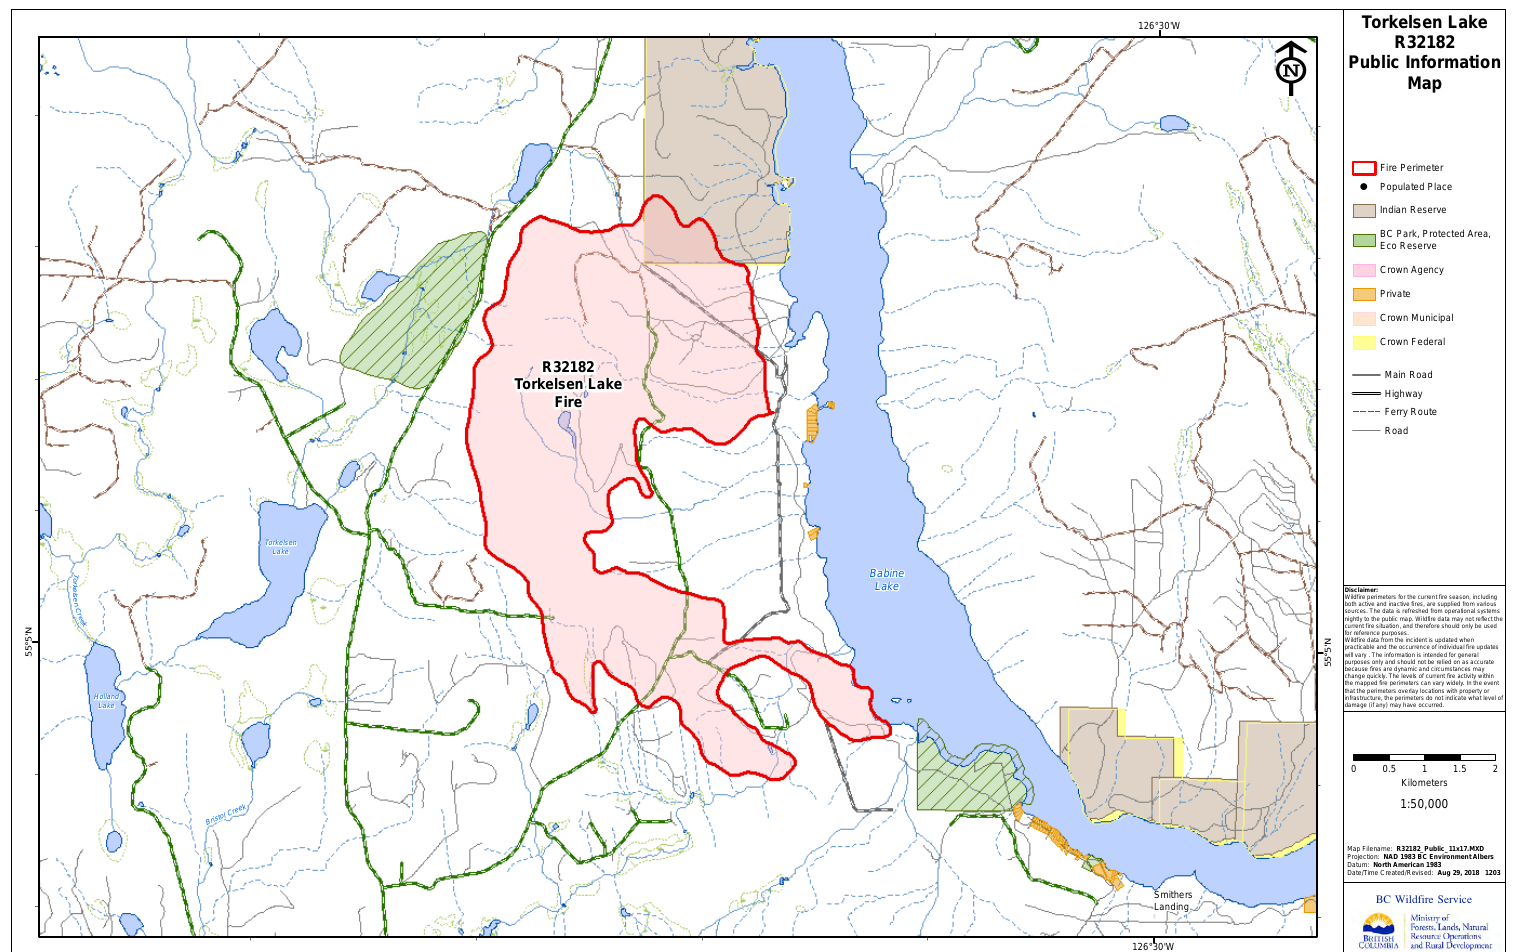
Figure 4. A map of the Torkelsen Lake Fire occurred in British Columbia, Canada, in 2018 (Map source: BC Wild Service, Ministry of Forest, Lands, Natural Resource Operation and Rural